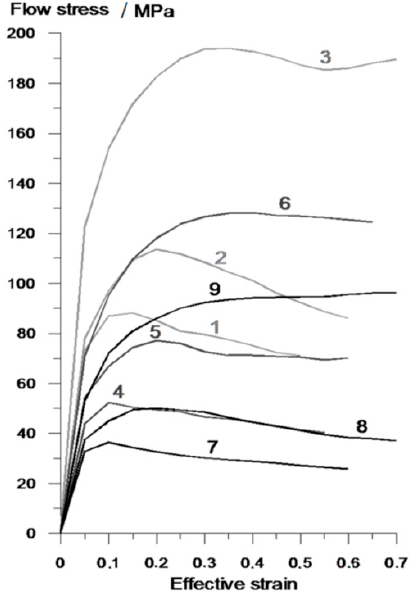
Figure 5. R200 steel flow curves used in finite element method (FEM) calculations: 1— T = 1000 °C, 𝜀(cid:4662) = 0.1 s − 1 ; 2— T = 1000 °C, 𝜀(cid:4662) = 1 s − 1 ; 3— T = 1000 °C, 𝜀(cid:4662) = 10 s − 1 ; 4— T = 1100 °C, 𝜀(cid:4662) = 0.1 s − 1 ; 5— T = 1100 °C,